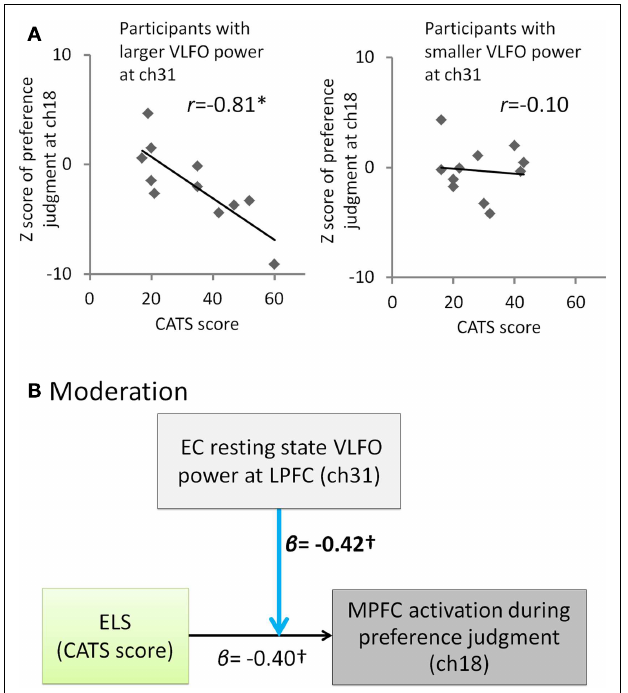
FIGURE 3 | Summary of the exploratory correlation and regression analyses for the relation among ELS, EC resting stateVLFO at LPFC, and MPFC activity during color-preference judgment . (A) Scatter plots and correlation coefficients between the ELS (CATS score) and the MPFC activation during the color-preference judgment ( z score at ch18) for each of the subgroups divided by the median of the EC resting-stateVLFO power at ch31. (B) Path model in which the effect from the ELS to the MPFC activation during the color-preference judgment was moderated by the LPFC resting-state activity. β represents standardized regression coefficient. *represents a statistically significant β value ( p < 0.05). † stands for marginally significant β value ( p < 0.10). Light blue arrows indicate a marginally significant moderation effect. Dashed arrow represent not significant β value ( p > 0.10). ELS is the early life stress. CATS stands for the Child Abuse andTrauma Scale. EC denotes eyes closed.VLFO denotes very low-frequency oscillations. MPFC denotes medial prefrontal cortex. LPFC denotes lateral prefrontal cortex.